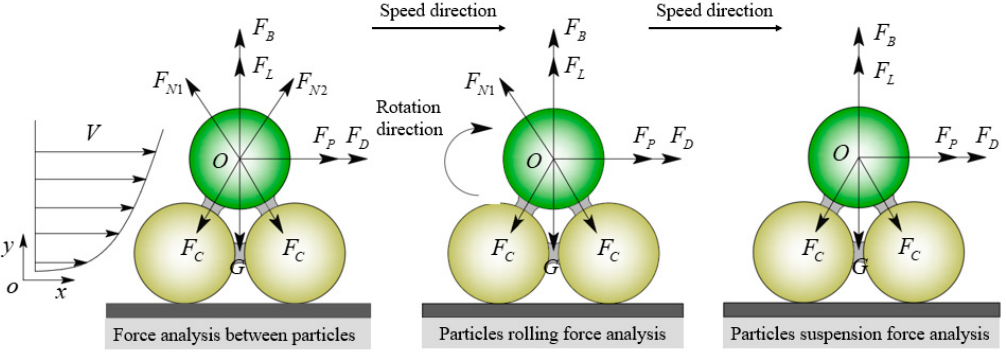
Figure 6. Schematic diagram of particle force analysis.